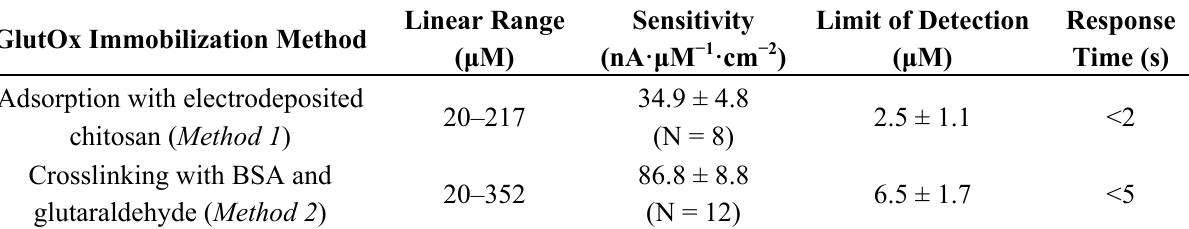
Table 1. Figures of merit of glutamate sensors prepared by Method 1 and Method 2